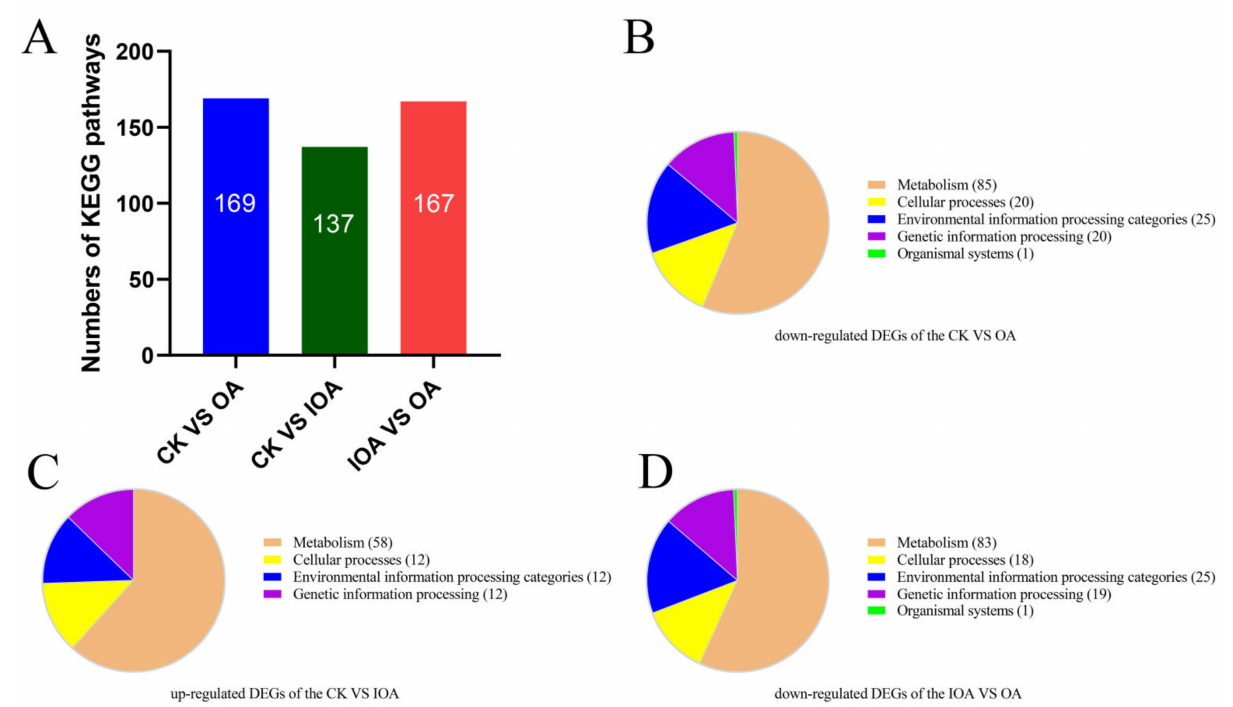
Figure 3. KEGG pathway classification enrichment analysis. ( A ) Number of KEGG pathways enriched for different groups. ( B ) Functional KEGG categories enriched by down-regulated DEGs in the OA vs. CK comparison. ( C ) Functional KEGG categories enriched by up-regulated DEGs in the IOA vs. CK comparison. ( D ) Functional KEGG categories enriched by down-regulated DEGs in the OA vs. IOA